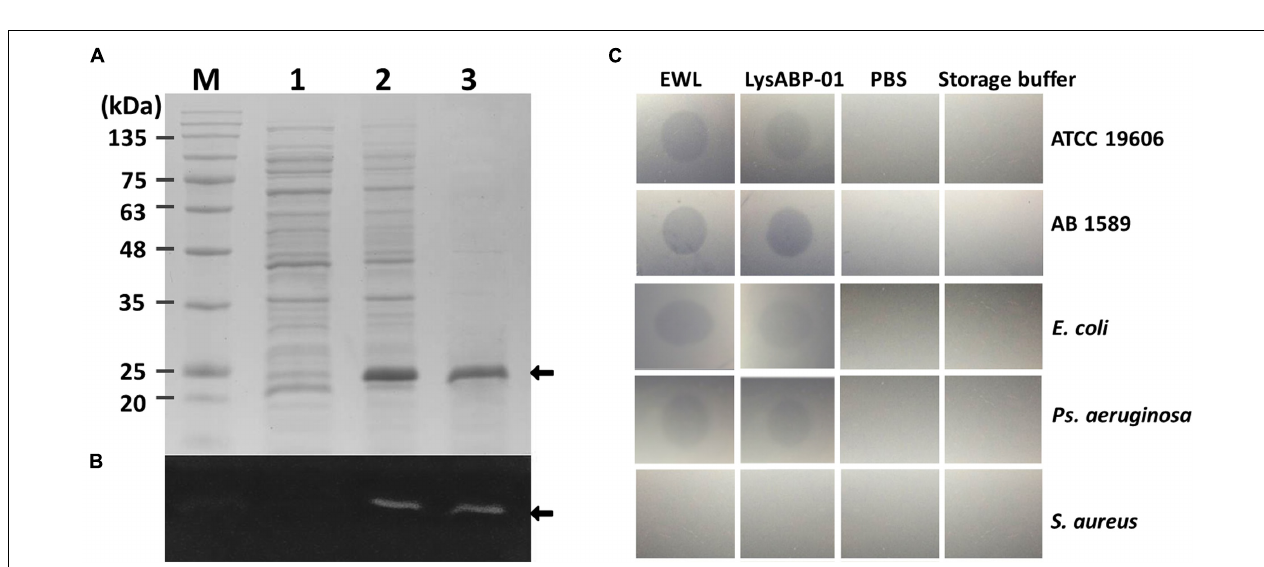
FIGURE 1 | Amino acid sequence alignment of LysABP-01. The sequences used for alignment analysis were LysAB2 (from phage φ AB2, accession no. ADX62345), PlyAB1 (from phage Abp1, accession no.YP_008058242) and LysABP-01 (from phage ØABP-01, accession no. AHG30899). Eleven mutation residues are indicated by asterisks ( ∗ ), five of which are found in conserved domain at positions 96, 100, 103, 108, and 111.